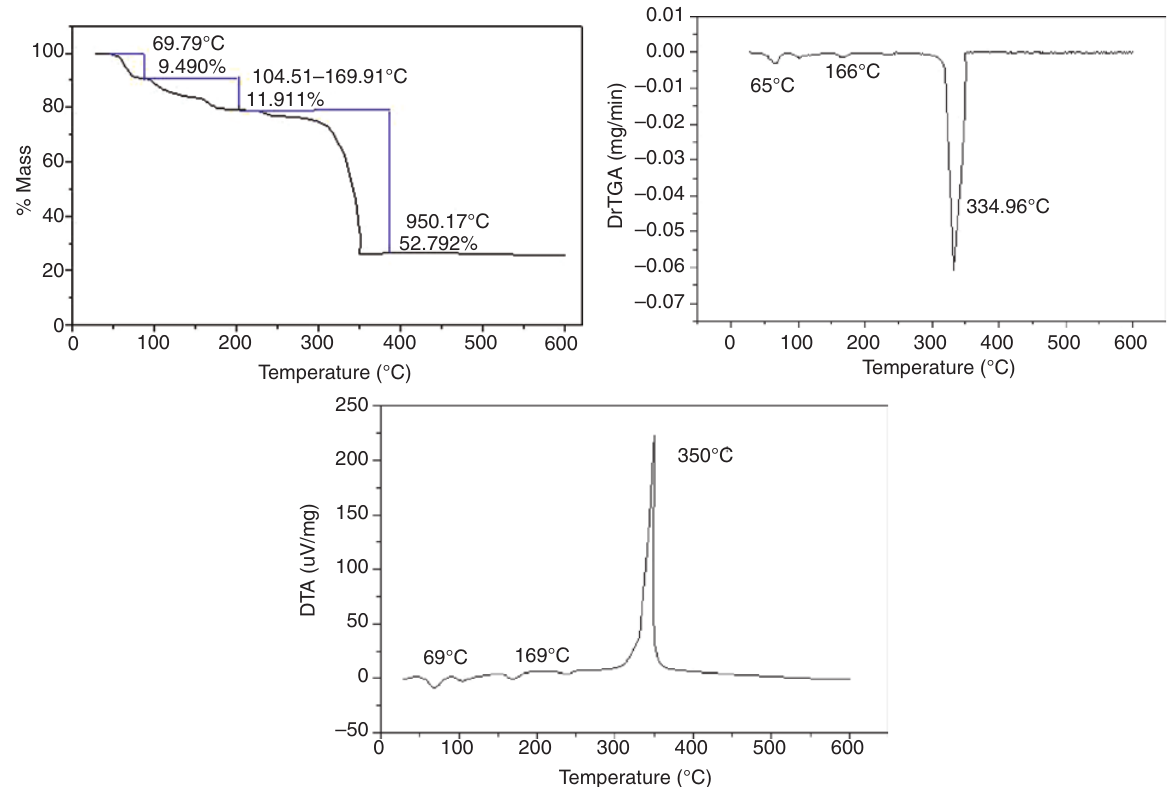
Figure 11: TGA, derivative thermogravimetry analysis (DrTGA), differential thermal analysis (DTA) plots of Cu-BTC, formed from Cu and benzene-1,3,5-tricarboxylic acid, synthesized in DD2, hydrated during 20 min.